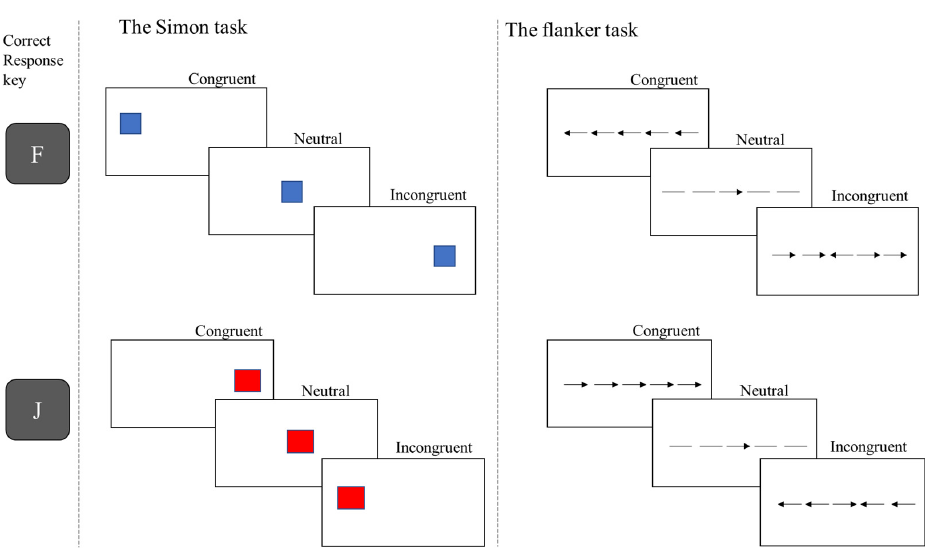
Figure 1. Typical trial conditions on the Simon and flanker